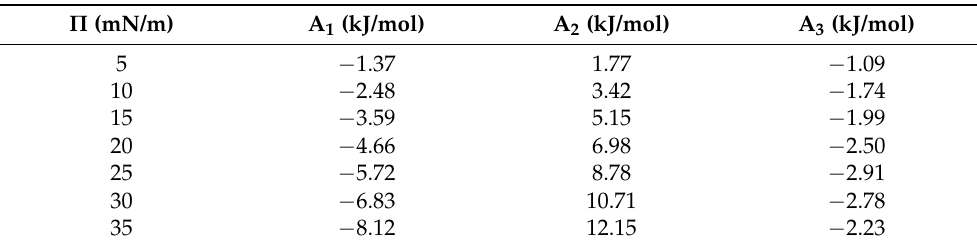
Table 2. Coefficient obtained for the best fit of the experimental data of the excess free energy for the mixture to Equation (10) at 35 ◦ C.